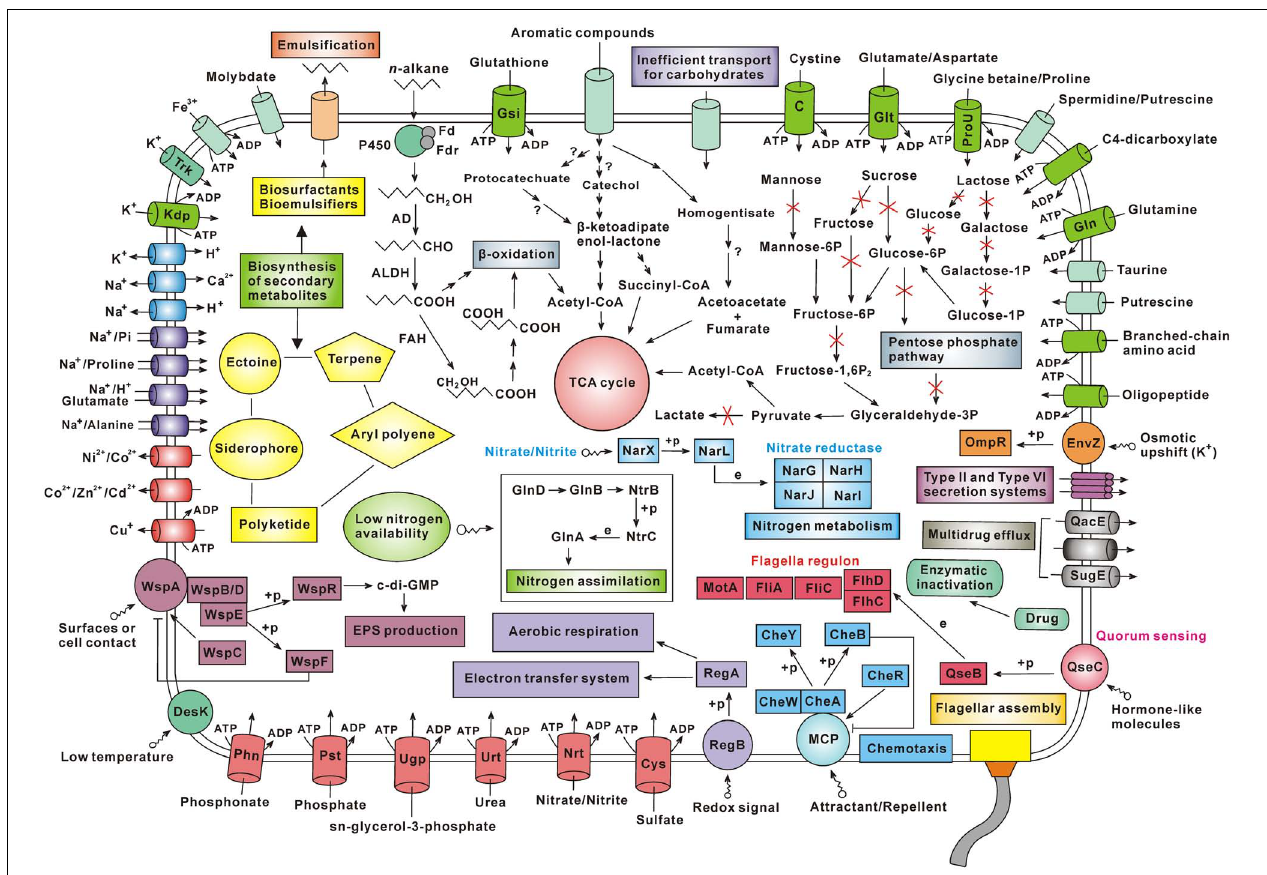
FIGURE 6 | Schematic overview of the metabolism and material transport in Achromobacter sp. HZ01. Primary information: (i) the n -alkane degradation in strain HZ01 is performed via the terminal oxidation pathway, and the catechol pathway may play a major role in the degradation of aromatic compounds; (ii) the inefficient carbohydrate transport and the lack of some key enzymes account for the bacterial inability to utilize several common carbohydrates for growth; (iii) strain HZ01 harbors the genes related to biosynthesis of secondary metabolites; (iv) the membrane transporters are essential for nutrient uptake and substance export; (v) strain HZ01 contains important two-component systems for the responses to environmental changes; (vi) the chemotaxis and flagellar assembly are beneficial for pursuing nutrients and avoiding environmental damages; (vii) besides through the enzymatic inactivation of antibiotics, strain HZ01 contains efflux pumps for elimination of antibiotics. Not all the metabolic pathways and transporters are shown in the figure. Import or export of solutes is indicated by the direction of the arrow through the transporter. The arrow with a red X shape indicates that the metabolic step is absent. The arrow with a question mark indicates that it is unsure whether the corresponding step can be completed. Abbreviations: Fd, ferredoxin; Fdr, ferredoxin reductase; P450, cytochrome P450; AD, alcohol dehydrogenase; ALDH, aldehyde dehydrogenase; FAH, fatty acid hydroxylase; +p, phosphorylation; e, expression; Trk, potassium transporter Trk; Kdp, Kdp system for potassium transport; EPS, extracellular polysaccharide; Phn, phosphonate transport system; Pst, phosphate transport system; Ugp, sn-glycerol-3-phosphate transport system; Urt, urea transport system; Nrt, nitrate/nitrite transport system; Cys, sulfate transport system; MCP, methyl-accepting chemotaxis protein; Gln, glutamine transport